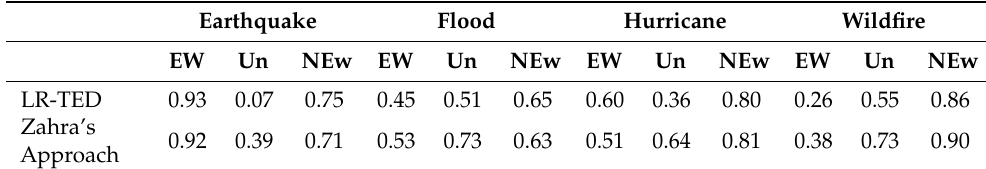
Table 11. Comparison of LR-TED and Zahra’s